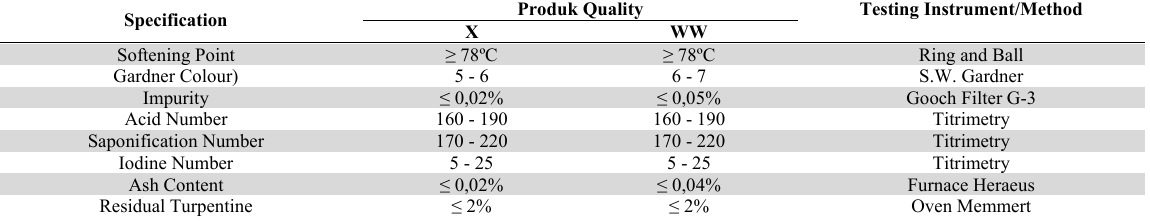
Technical Data Sheet (TDS) Gum Rosin Garde X &